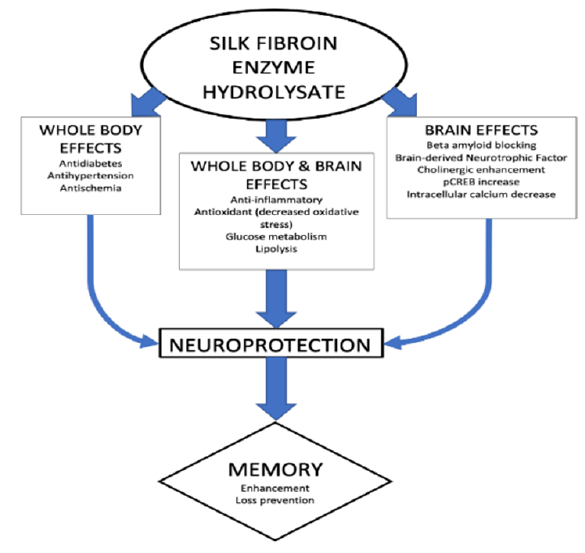
Figure 1. Multiple mechanisms for effects on memory of silk fibroin enzyme hydrolysates.